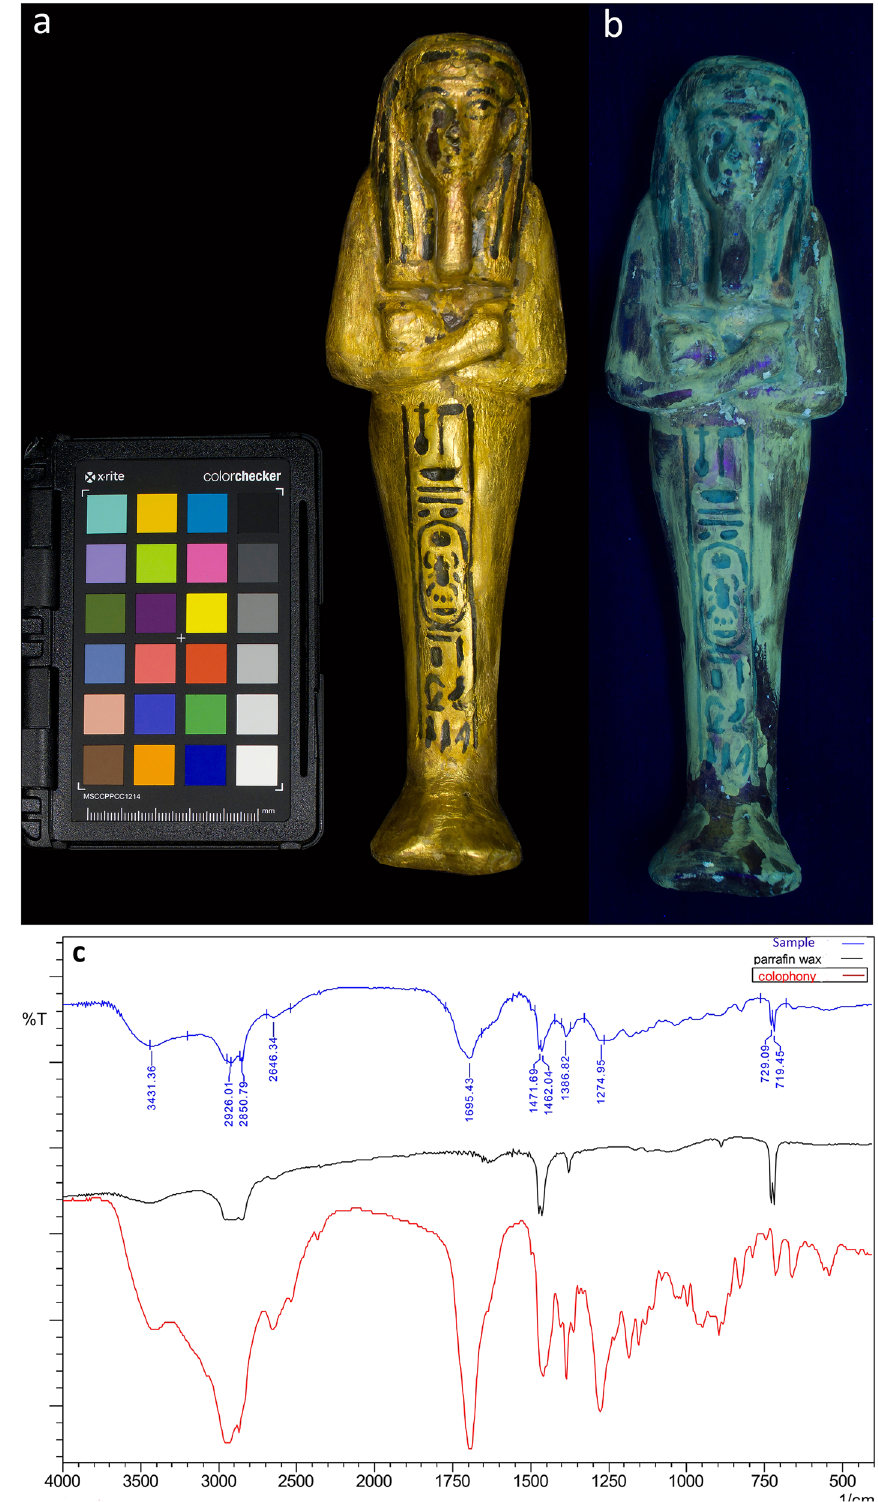
Figure 10: Analytical characterization of the previous resinous fi lls on the outer surface of Object GEM 3467: ( a ) visible image; ( b ) UV luminescence image; and ( c ) FTIR spectrum of sample